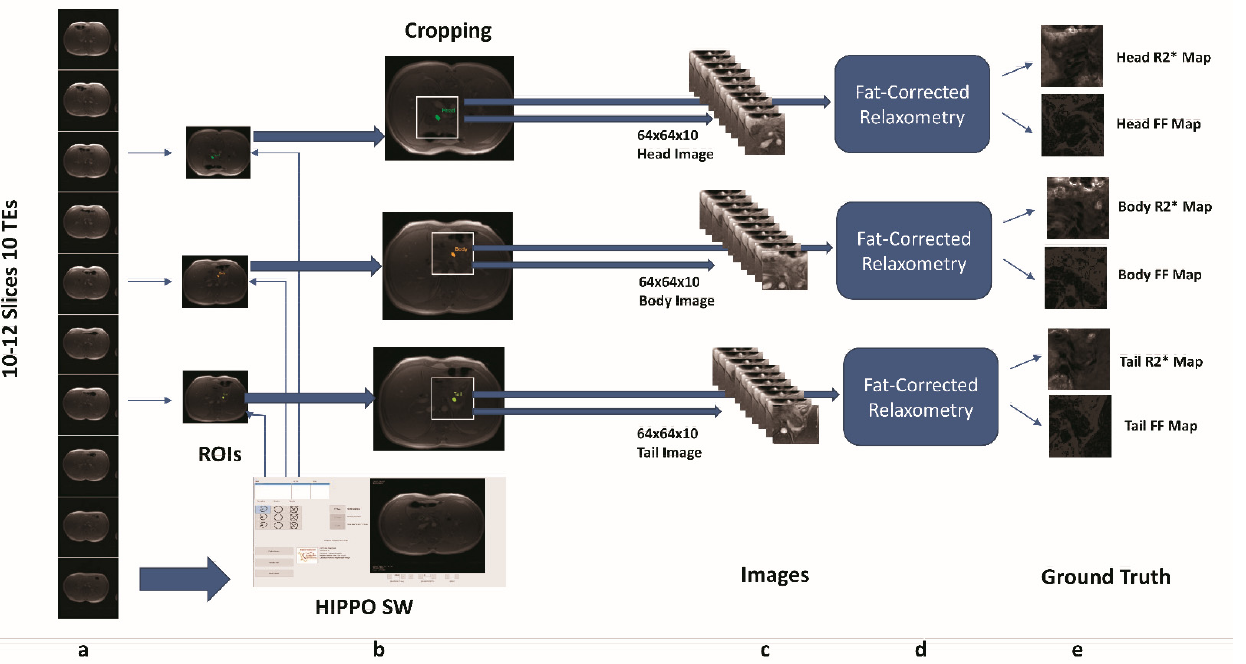
Figure 1. Ground truth data generation. ( a ) original MR image data; ( b ) ROIs encompassing pancreatic regions; ( c ) cropped 64 × 64 × 10 MR images; ( d ) Fat-corrected relaxometry processing; ( e ) corresponding R2* and FF maps representing the Ground Truth for U-Net training and validation.